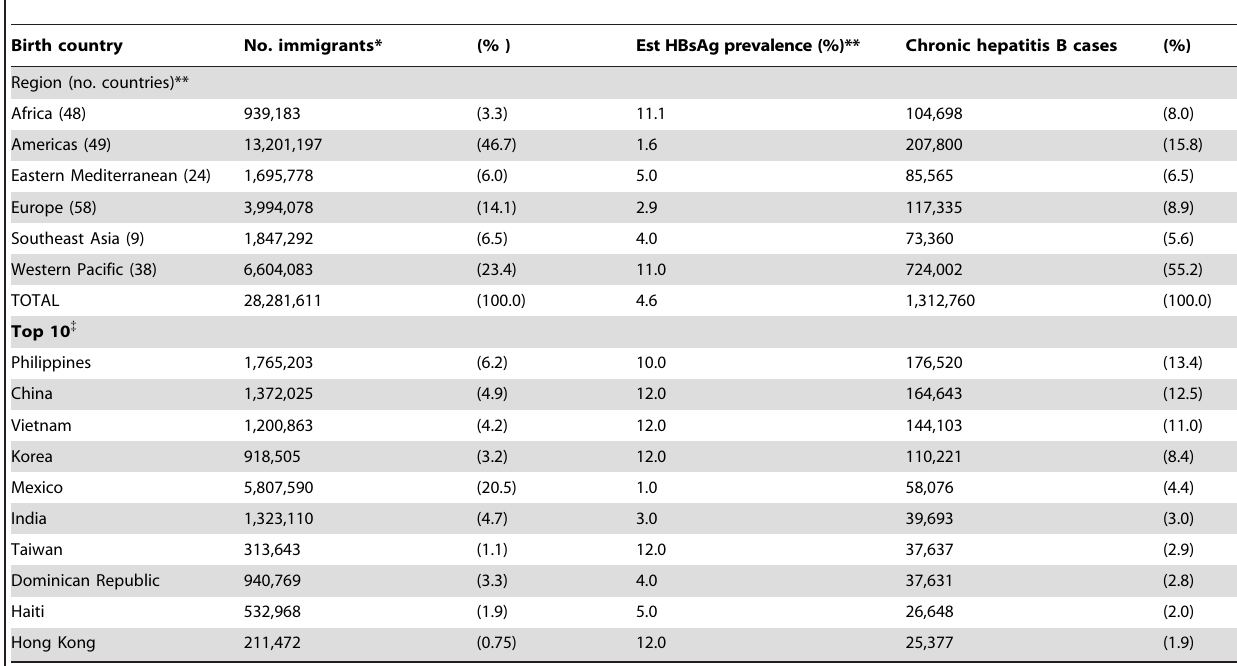
Table 1. Number of Immigrants, Estimated HBsAg prevalence, and number of imported chronic hepatitis B cases by country of birth, 1974–2008.